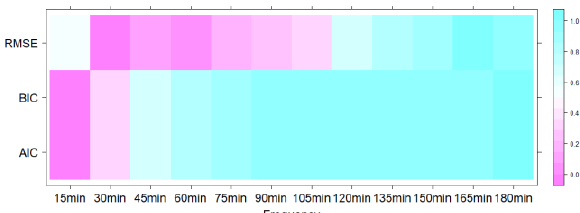
Figure 5. Levelplot of the time series forecast metrics (AIC, BIC, RMSE) across the entire range of